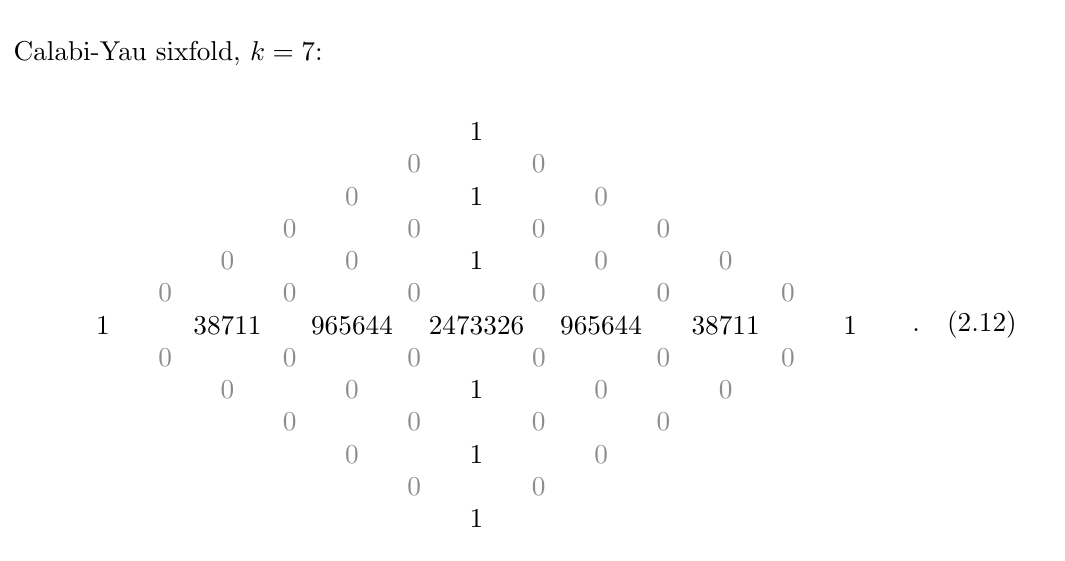
Table 1. Euler characteristic (cid:31) ( X ) of ( k (cid:0) 1)-dimensional Calabi-Yau hypersurfaces X in WP 1 ;:::; 1 ;k for low values of k